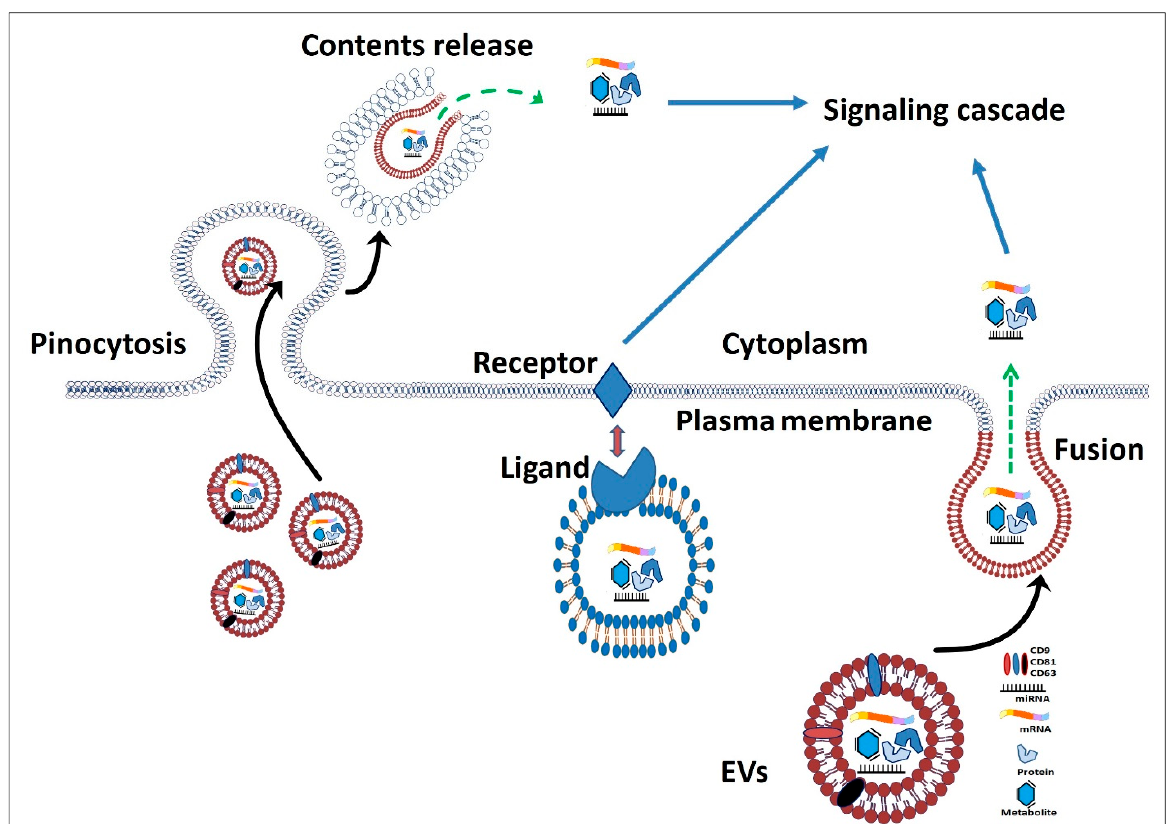
Figure 1. Schematic illustration of extracellular vesicles (EVs) uptake and cargo release to the target cells. EVs can fuse with the plasma membrane and deliver the molecular cargo into the cytoplasm. The EV surface protein can interact with cell receptors and deliver a signal pathway. EVs may be up-taken into the cells through pinocytosis where lysosomes can recycle or release their contents into the cytoplasm. The molecular contents of the EVs reflect the cell of origin and exhibit their actions when they become free from the lipid bilayer.